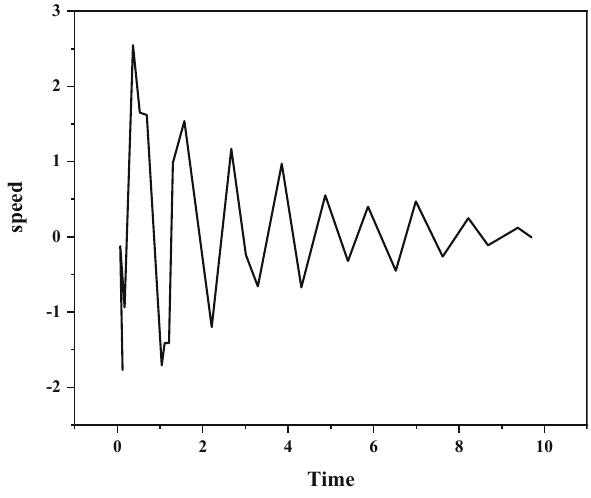
Figure 2: Historical ramp time